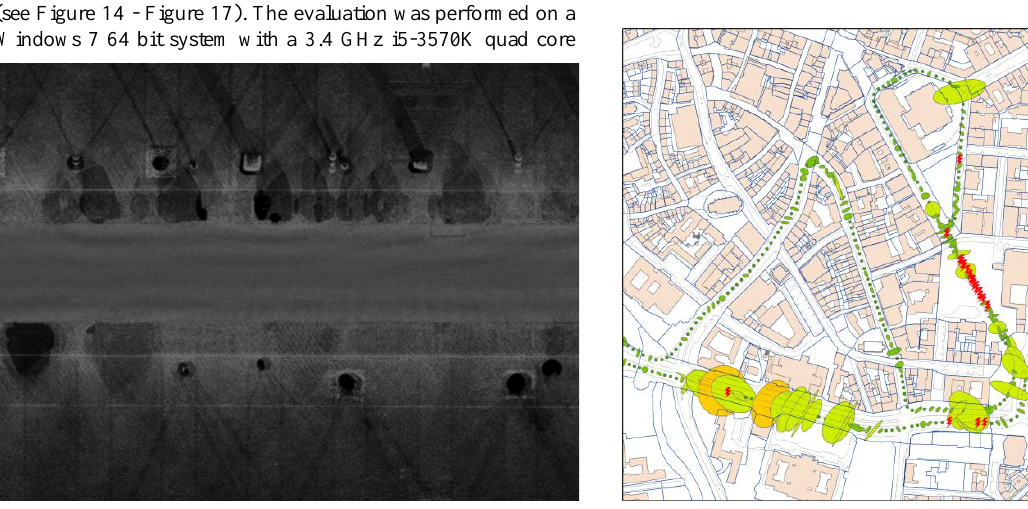
Figure 10: Intensity image of a trajectory point, where a correct localization fails.